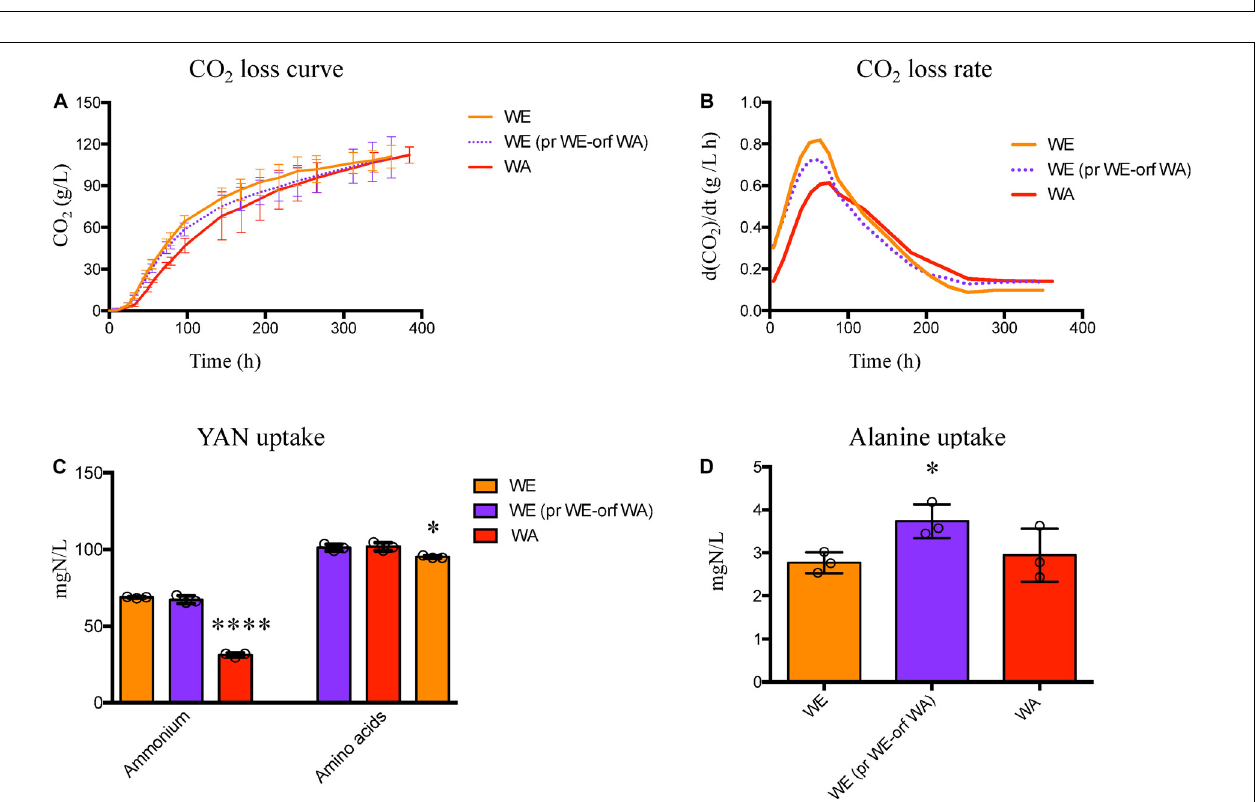
FIGURE 6 | Fermentation performance for the WE strain with GTR1 allele swapping. (A) Fermentative performance was evaluated by CO 2 loss over the time and the kinetic parameters were extracted from the curves. (B) Maximum CO 2 loss rate was determined by calculating the first derivate of the CO 2 loss curve. (C) Ammonium and amino acids consumption for the WE strain with GTR1 ORF swapping and the wild type parental strains. (D) Alanine consumption for the WE strain with GTR1 ORF swapping and the wild type parental strains. Plotted values correspond to the average of three biological replicates (dots), with their standard error represented by bars (mean ± SE). The asterisks represent different levels of significance between the phenotypes of strains constructed and wild type strains ( t -test; * p < 0.05 and **** p < 0.0001). WE, Wine/European; WA, West African; pr, Promoter; orf: Open Reading Frame